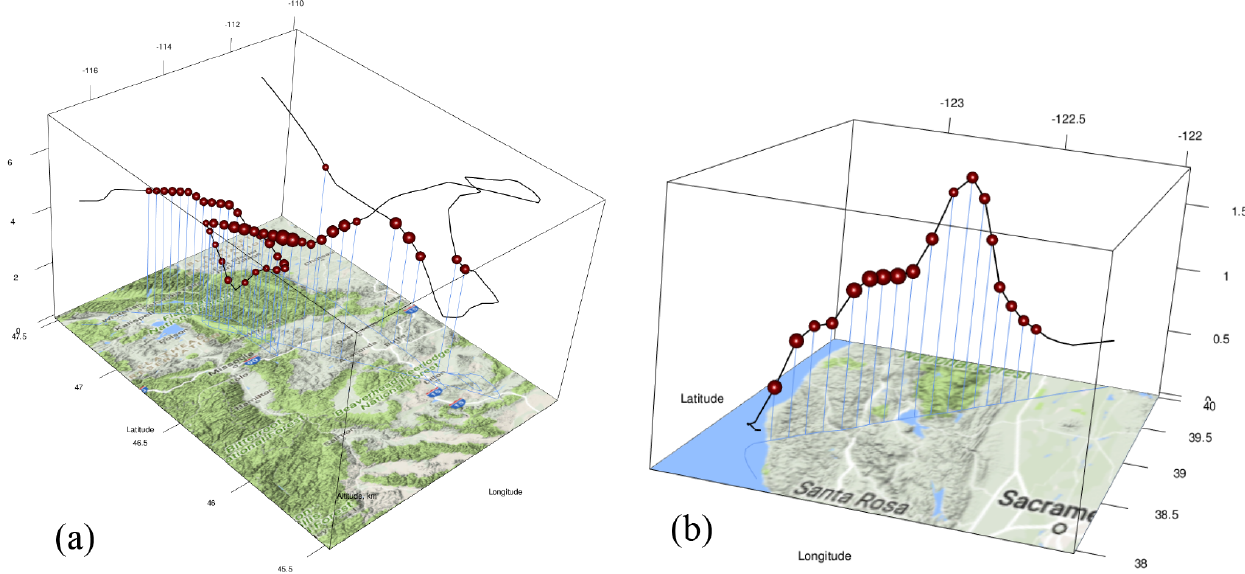
Figure 3. Flight paths and locations of plumes for two fire samples. (a) Sampling over Montana during SEAC4RS Flight 10. (b) Sampling in a cross-mountain transect along the Northern California coast. The size of the spheres indicates the relative amount of biomass-burning contribution. Numerical values of the contribution are in a later figure, Fig. 10. Some of the information was converted from © Google Maps using the R programming